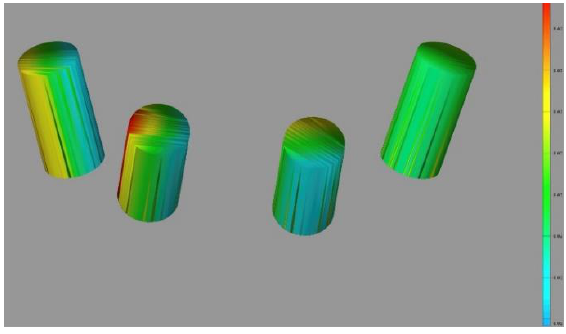
Figure 9. Colorimetric analysis (GOM inspect) of the four-implant impression using the prosthetic Figure9. template.